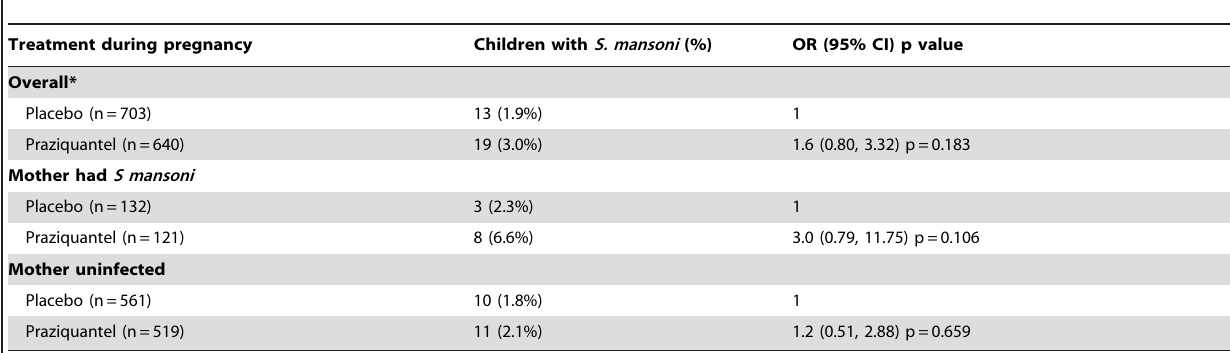
Table 3. Effect of praziquantel treatment during pregnancy on S. mansoni infection status in children at age five years.